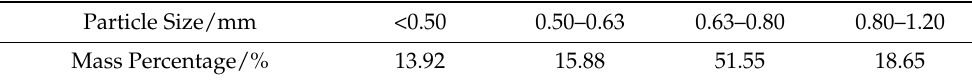
Table 3. Particle size distribution of the